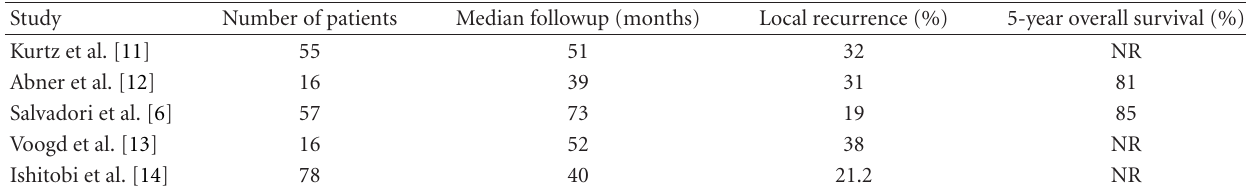
Table 1: Outcomes of patients treated with breast conserving surgery alone following in-breast local